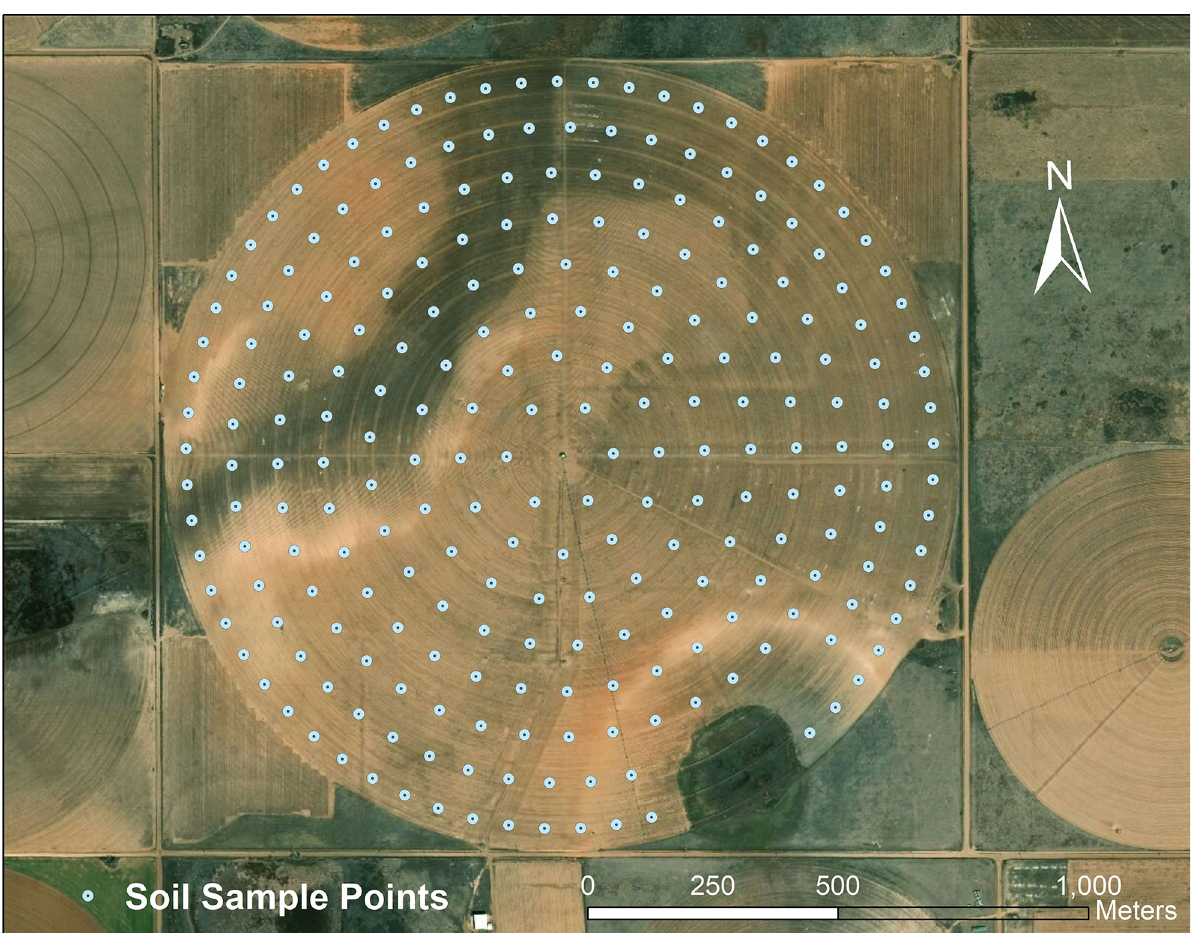
Fig 4. Soil sampling design for a 194-ha farm in Hale County, Texas in 2017 (basemap source: Esri, DigitalGlobe, GeoEye, i-cubed, USDA FSA, USGS, AEX, Getmapping, Aerogrid, IGN, IGP, swisstopo, and the GIS User Community).